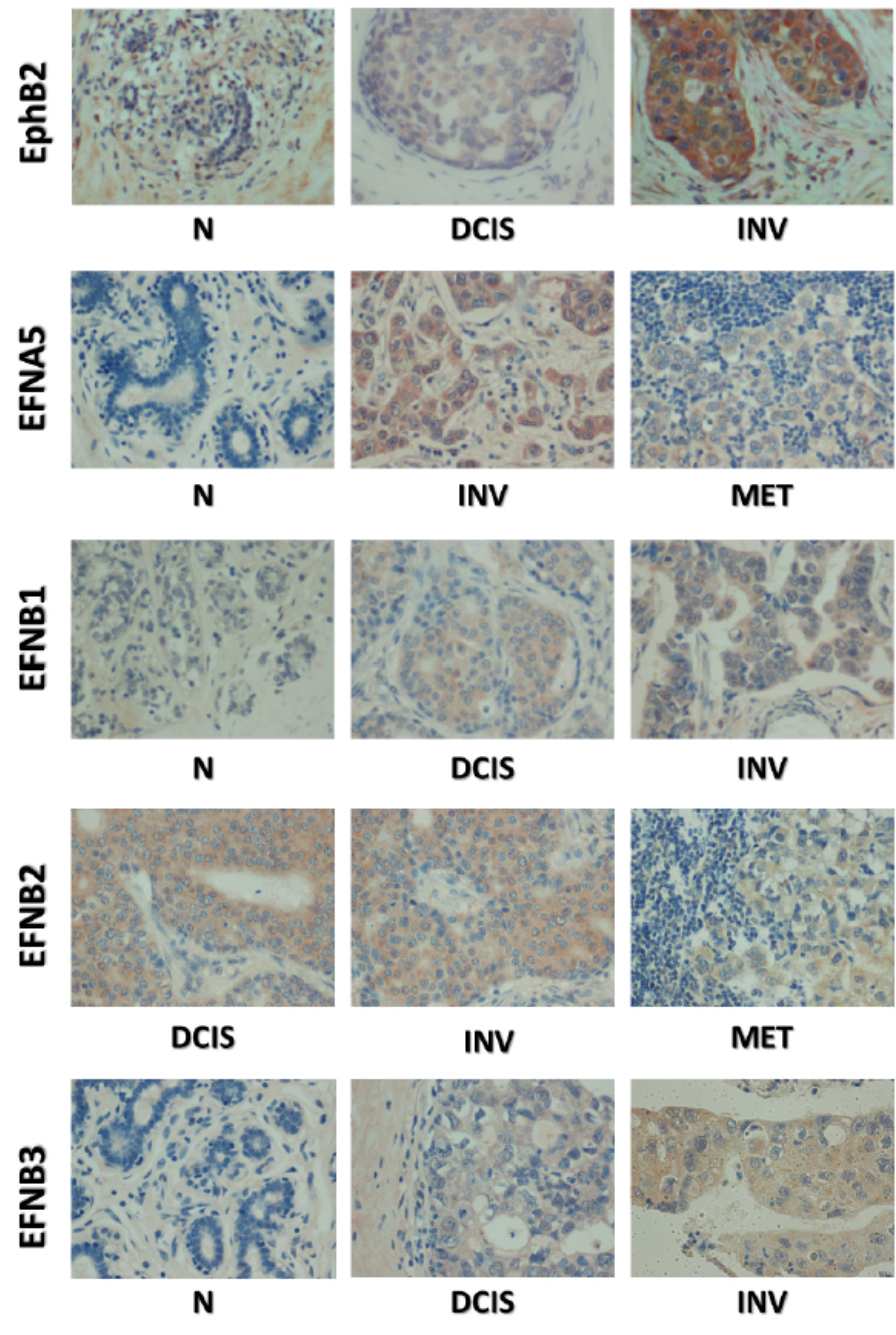
Figure 4. Immunohistochemical staining of EphB2 and cognate ephrin ligands in human breast clinical specimens. Representative microphotographs were taken at × 200 magnification, and include normal samples (N), ductal carcinomas in situ (DCIS), invasive carcinomas (INV), and metastases (MET).